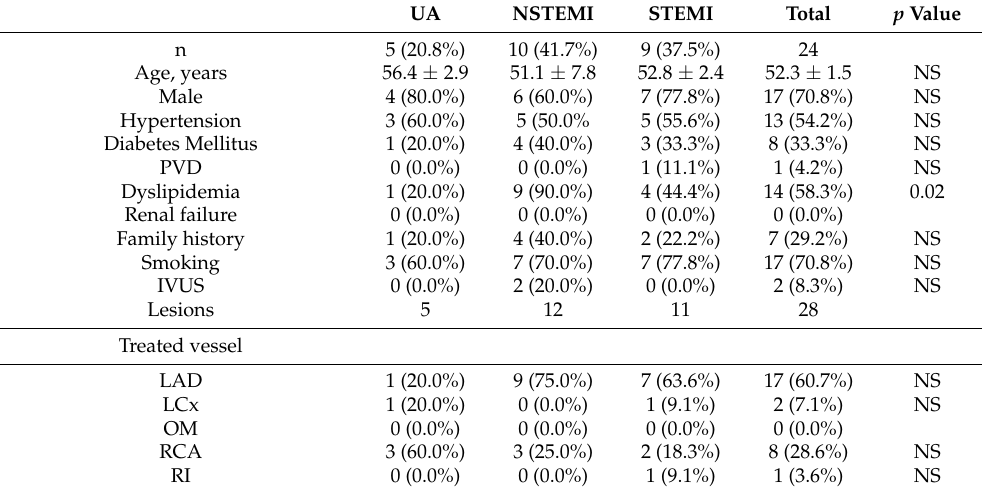
Table 3. Acute coronary syndrome general patients and procedure